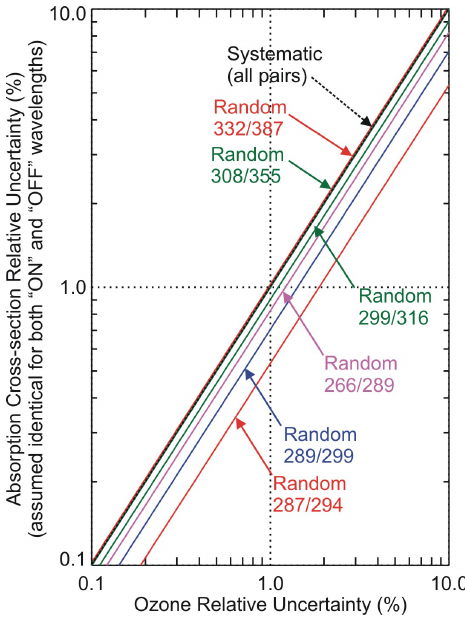
Figure 7. Ozone relative uncertainty (%) as a function of absorption cross section relative uncertainty (%), assuming that all cross sec- tions have the same relative uncertainty. Solid red, green, blue, and purple curves are used for cases of independent (random) datasets, and a dashed black curve is used for the case of full correlation be- tween all cross sections